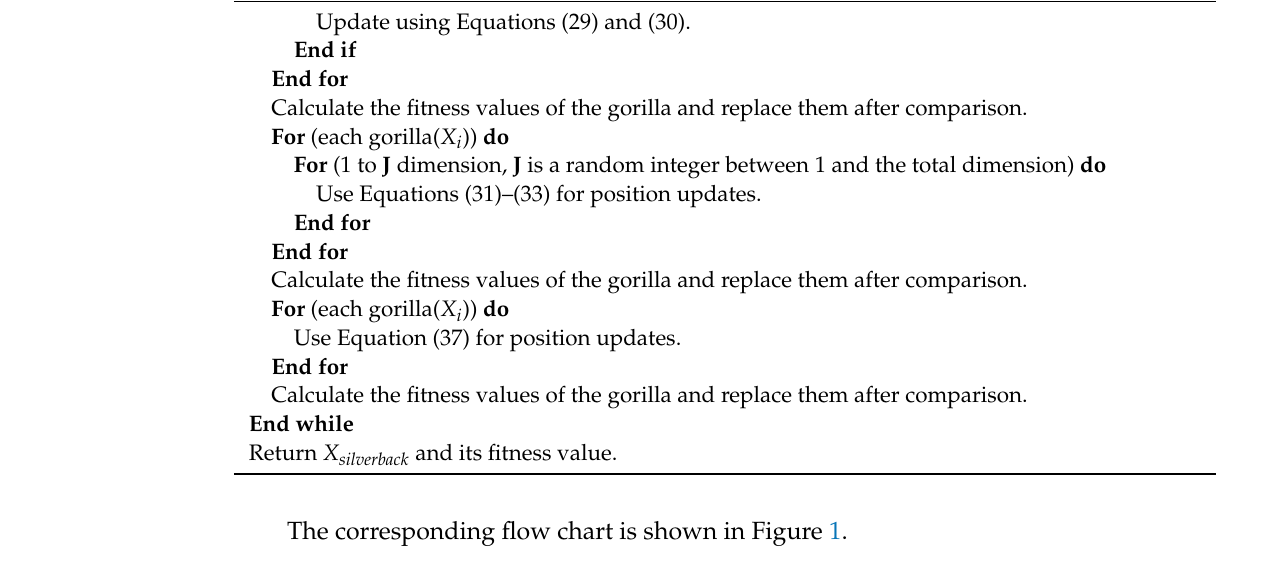
Algorithm 1: Pseudocode of MGTO algorithm